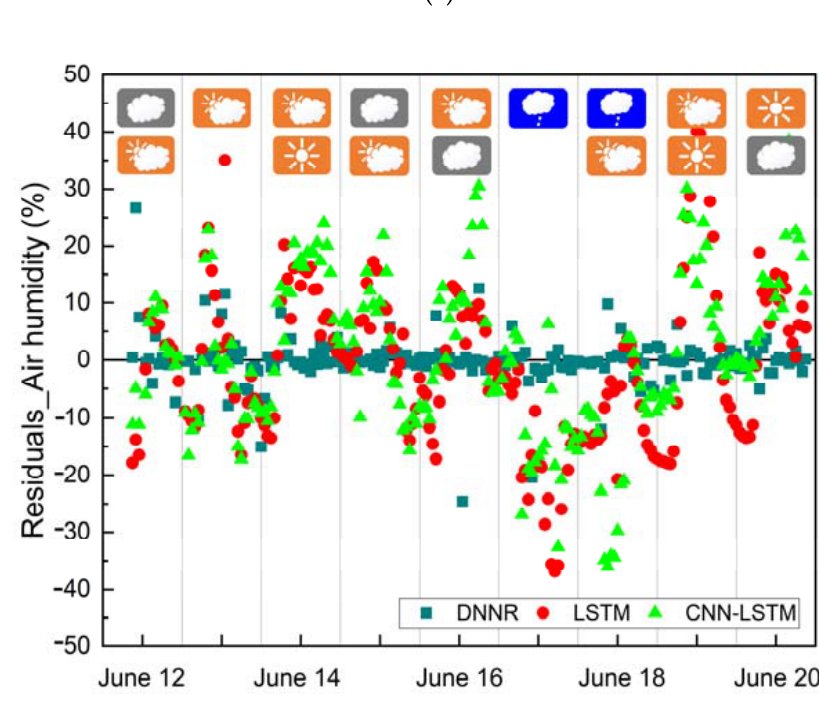
Figure 18. The ST of the three model errors for Greenhouse B humidity under different weather conditions; ( a ) 3 h advance, ( b ) 6 h advance, ( c ) 12 h advance, ( d ) 24 h advance.